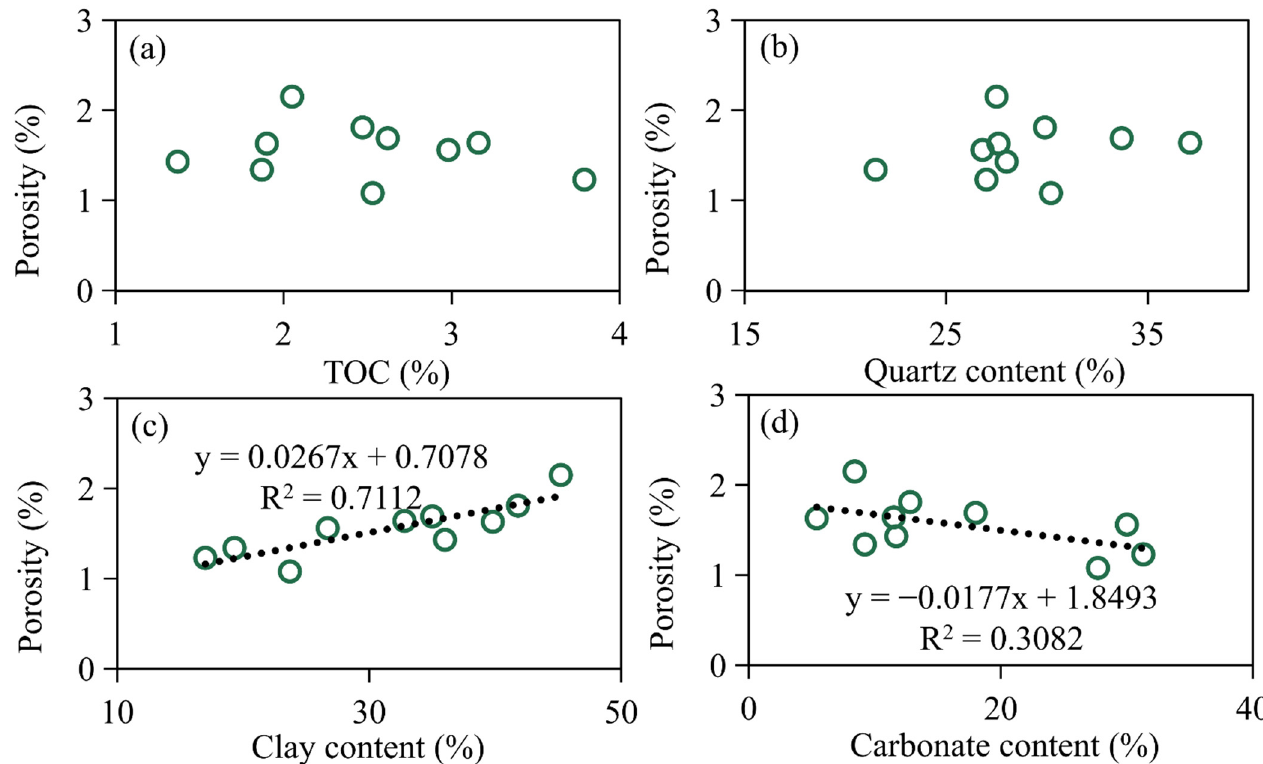
Figure 6. Plots showing relationships of porosity with TOC ( a ), quartz ( b ), clay mineral ( c ), carbonate ( d ) content for the YC2 samples.